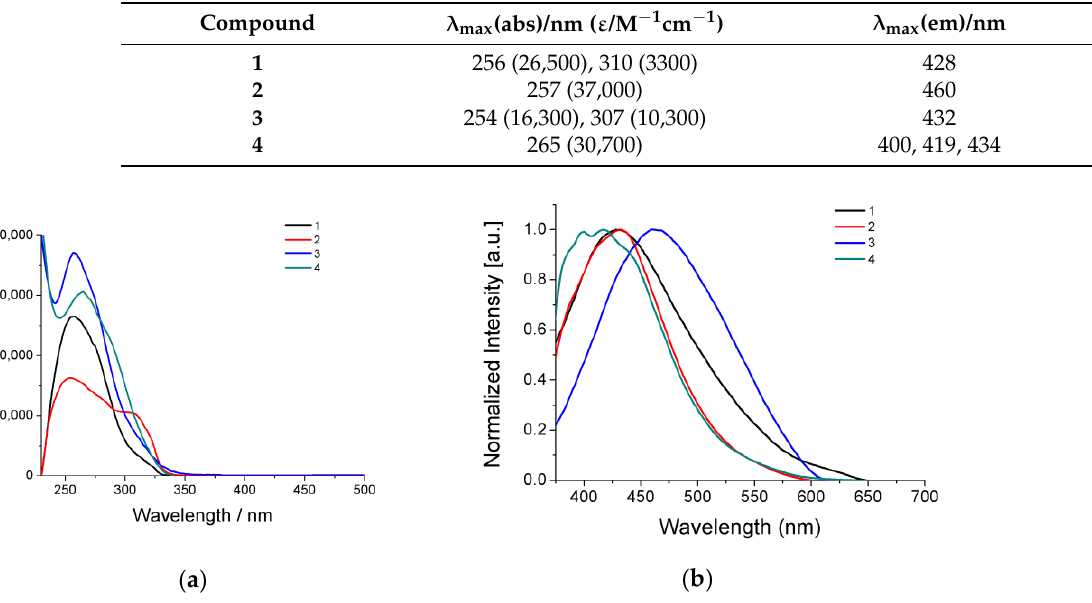
Figure 2 (a) UV – visible electronic absorption spectra of compounds 1 – 4 in CH 2 Cl 2 solutions (~5 × 10 ‒5 M). (b) Emission spectra of compounds 1 – 4 in DMSO solutions (~5 × 10 ‒5 M).